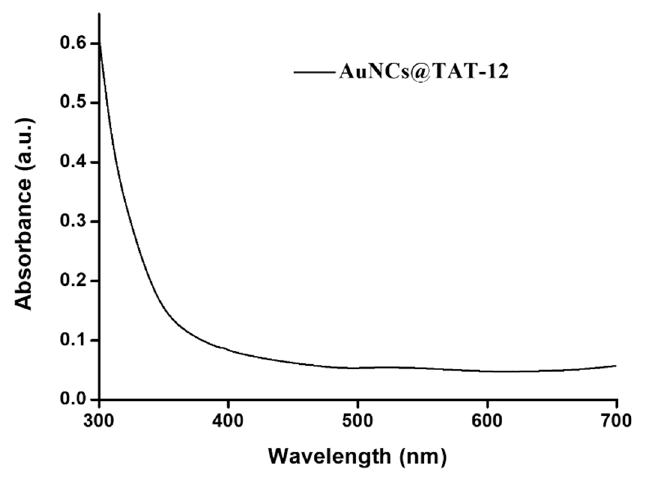
Figure 3. UV − vis absorption spectrum of AuNCs@TAT-12.